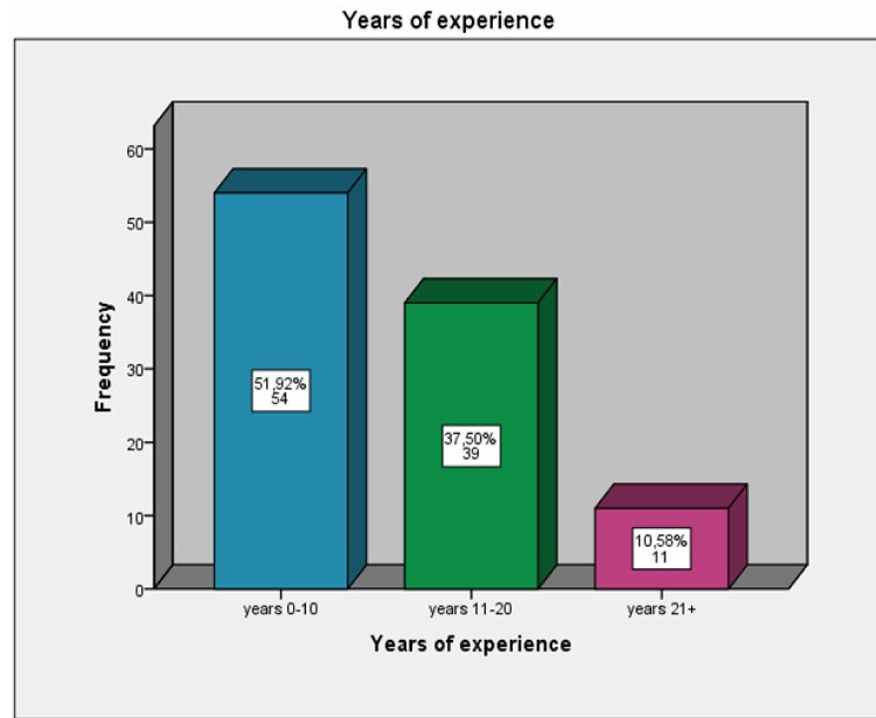
Figure 1. Years of clinical experience in orthodontics.